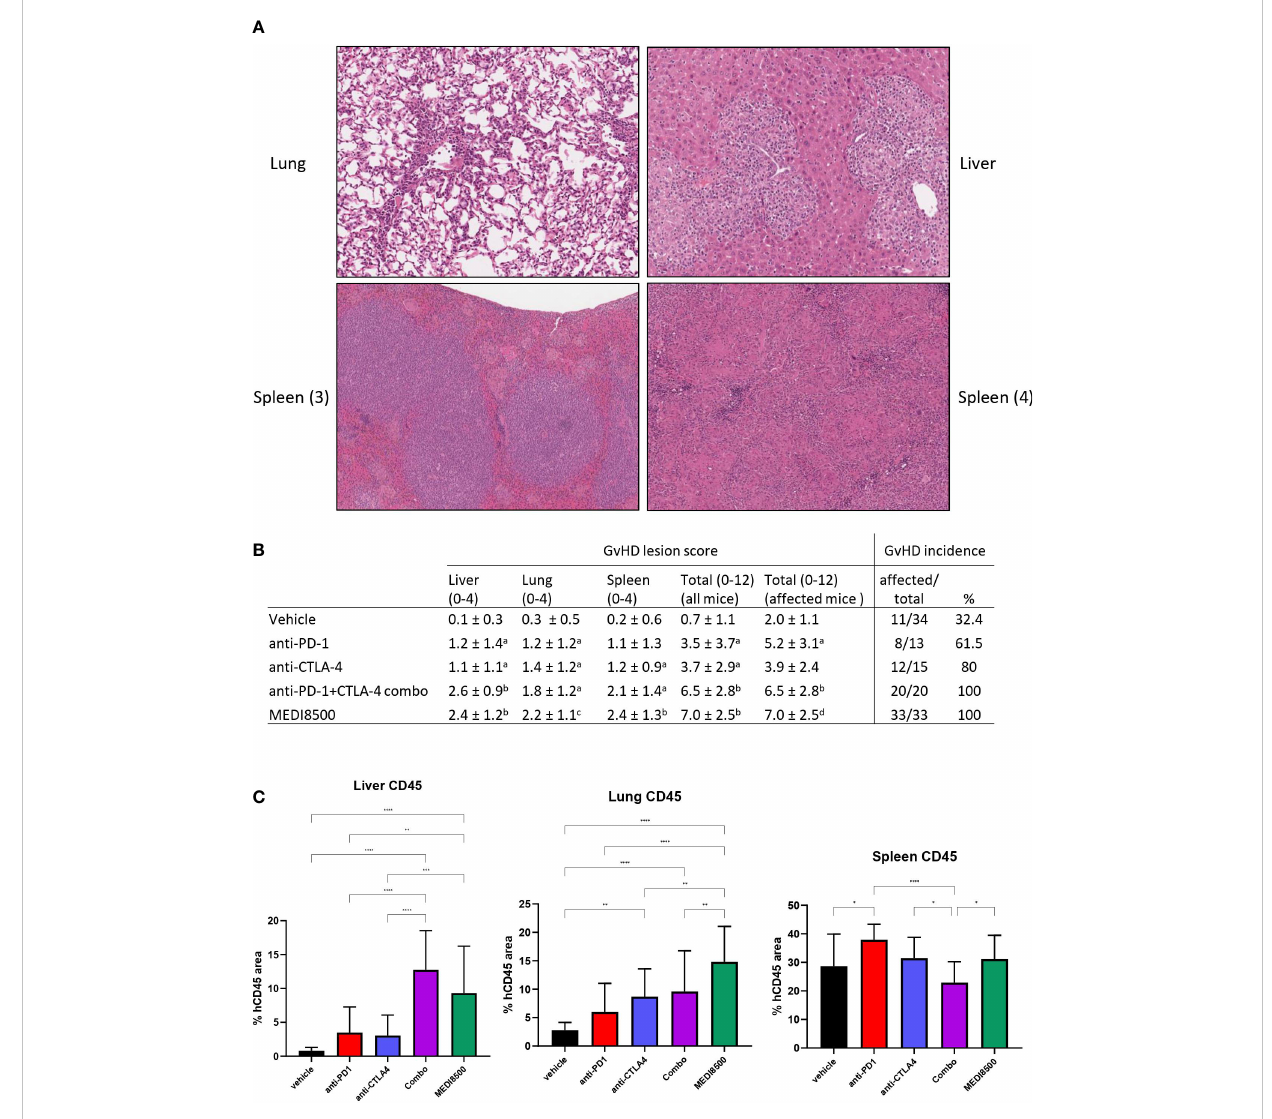
FIGURE 5 Greater GvHD lesion score with antibody combination and MEDI8500 compared to monotherapies. (A) Representative images of GvHD lesions in tissues: (1) lung, with vascular intimal, perivascular and interstitial lymphocytic in fi ltration (20x magni fi cation) (2) Liver, with portal in fi ltration with lymphocytes and macrophages extending to the lobular parenchyma (20x magni fi cation) (3) spleen, with expansion of white pulp by lymphocytes, and small macrophage nodules in the red pulp (10x magni fi cation) (4) spleen, with diffuse granulomatous in fi ltration with coalescing macrophage nodules (12x magni fi cation) (B) Histopathologic scoring of GvHD lesions, shown as mean ± SD per treatment group. Total score is sum of liver, lung and spleen scores. Mean total scores are calculated either for the whole group (including animals without any lesions), or excluding the animals without lesions. a signi fi cant difference (* P < 0.05) with vehicle, b signi fi cant difference (* P < 0.05) with vehicle, anti-PD-1 and anti-CTLA-4, c signi fi cant difference (* P < 0.05) with vehicle and anti-PD-1, d signi fi cant difference (* P < 0.05) with vehicle and anti-CTLA-4 (C) huCD45 positive cell in fi ltration in liver, lung and spleen, expressed as proportion of total tissue area. **P<0.01, ***P<0.001,